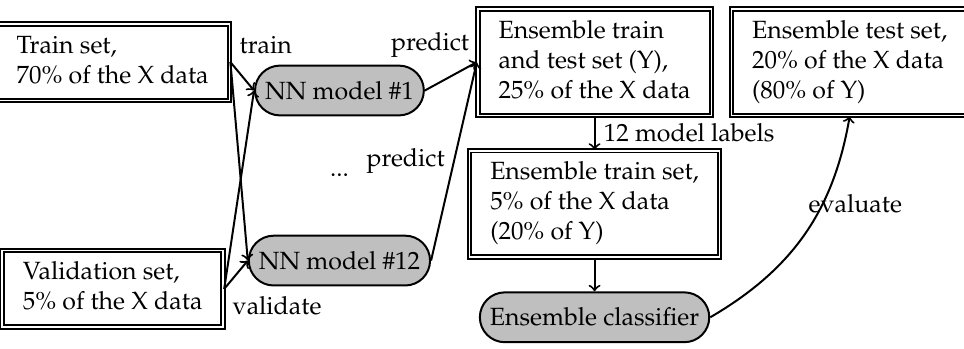
Figure 4. Pipeline of our approach for ensemble learning.